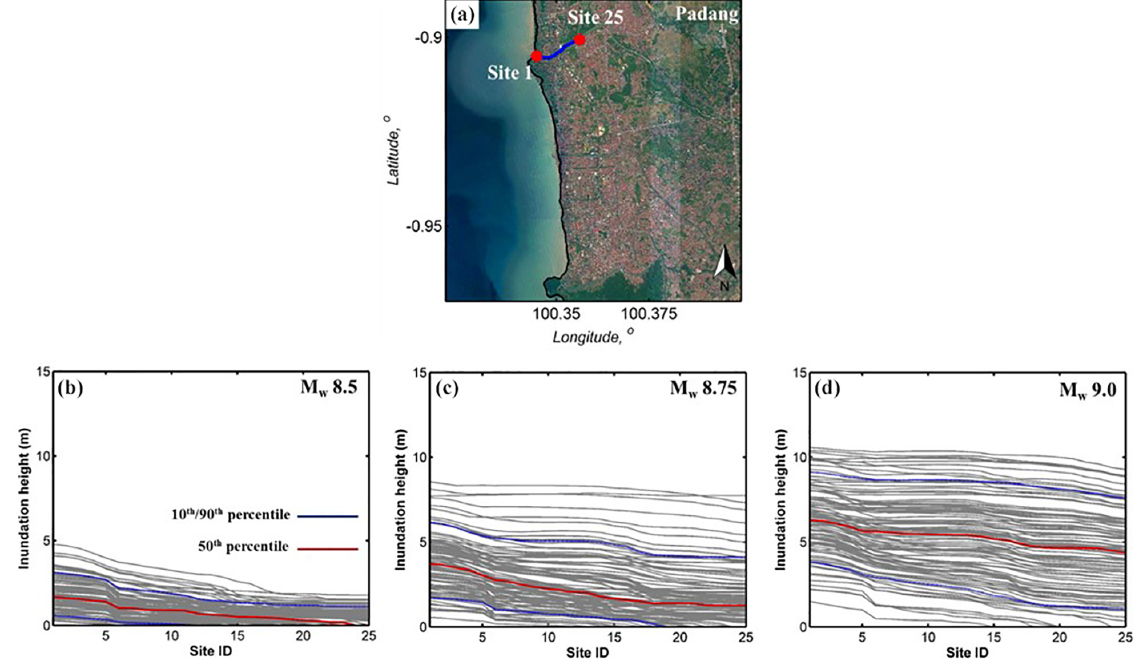
Figure 11. (a) Site location. (b) Maximum tsunami inundation height in the first river of Padang for the M w 8.5 scenario. (c) Maximum tsunami inundation height in the first river of Padang for the M w 8.75 scenario. (d) Maximum tsunami inundation height in the first river of Padang for the M w 9.0